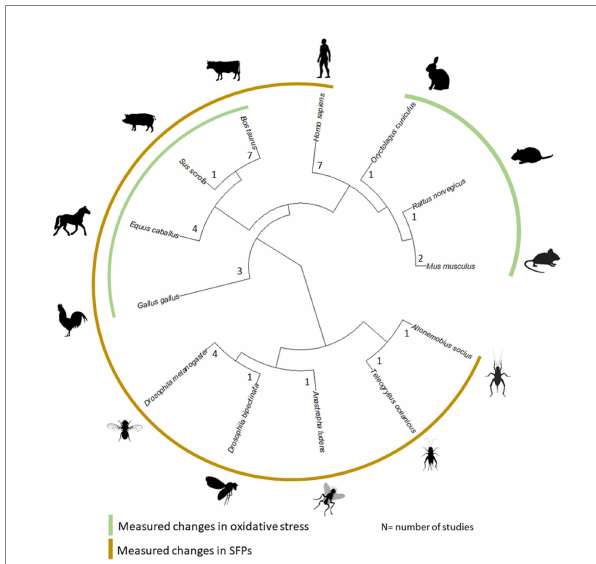
FIGURE 1 Phylogenetic distribution of all species in our review across 34 studies along with the number of studies on each. Species which had data reported for age-dependent changes in SFPs and oxidative stress are marked. Images to generate the figure were taken from the Open Tree of